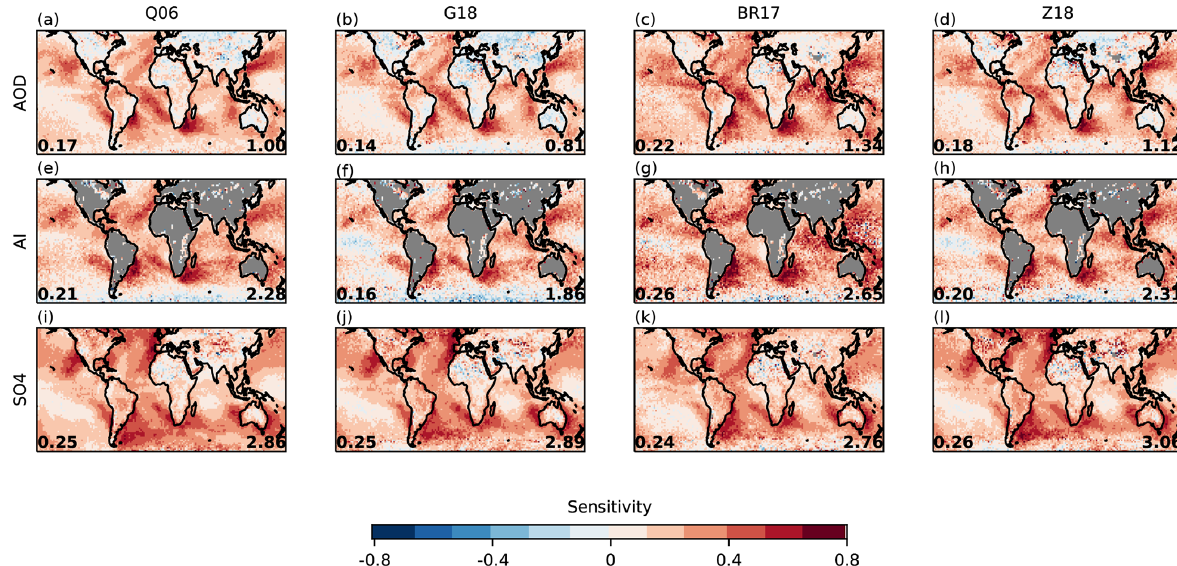
Figure 9. Maps of the sensitivity of N d to a selection of aerosol proxies ( β N ). Each plot shows the global mean β N in the lower left and the ratio of the implied RFaci to that calculated using Q06 N d and AOD (a) in the lower